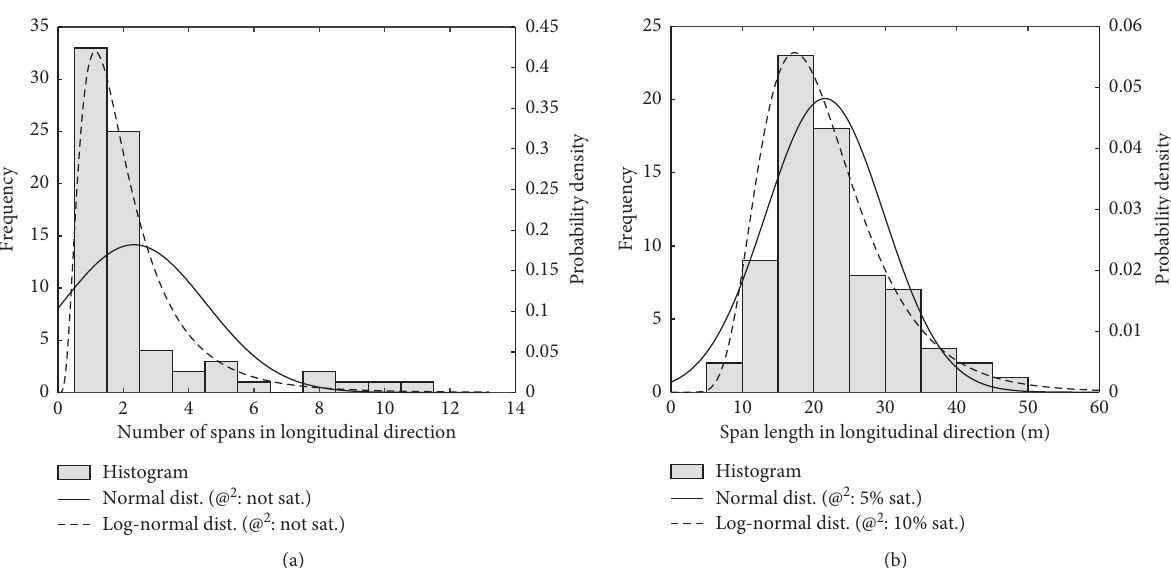
Figure 12: Histogram and probability distributions associated with the (a) number and (b) length of the spans (in the longitudinal direction).